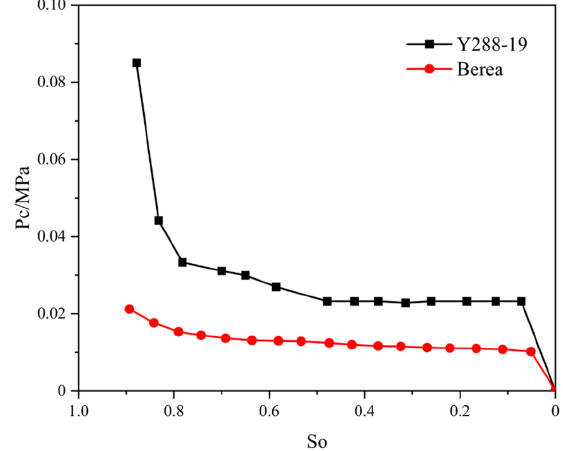
Figure 15. Capillary pressure curve of two types of cores.